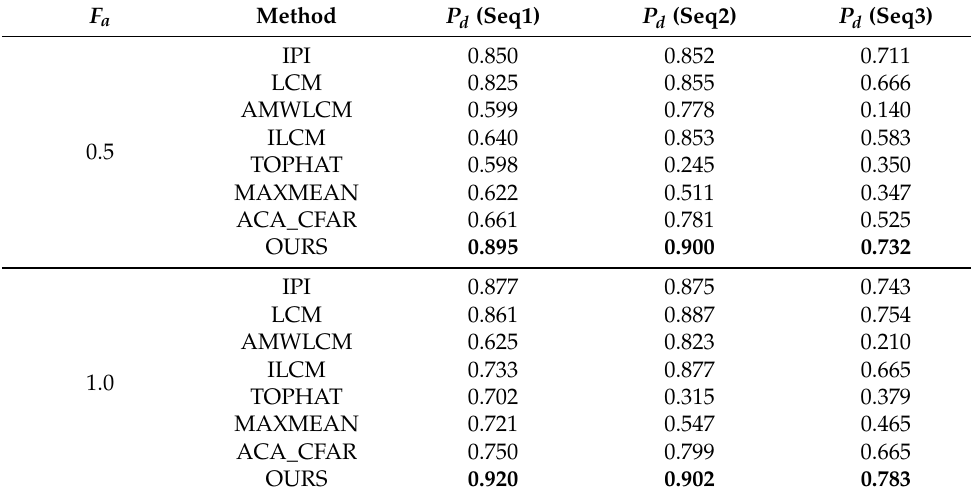
Table 3. Probability of detection for different algorithms.